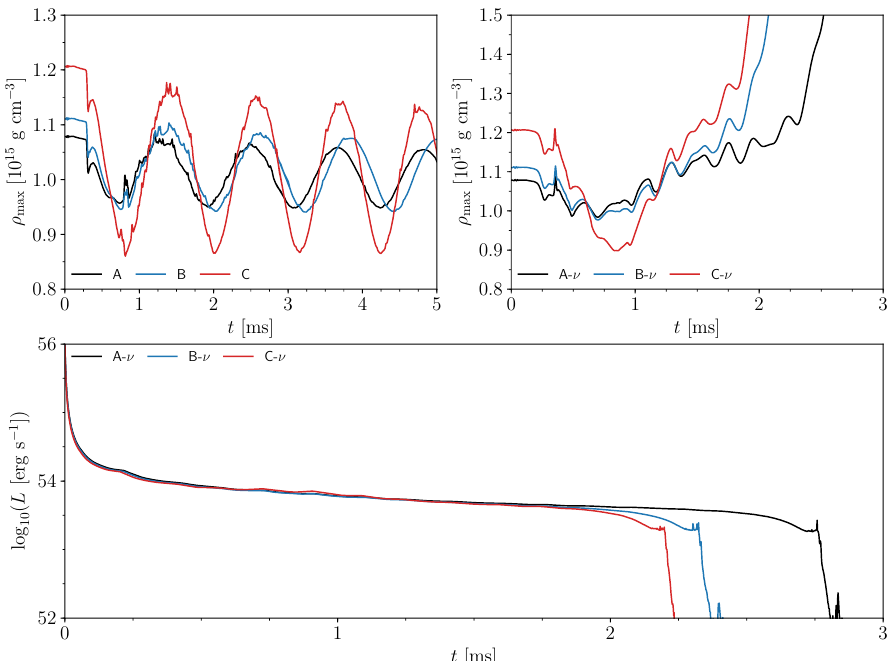
Figure 2. Time evolution of quantities of interest. Upper panels: central rest-mass density for simulations A, B, and C. Left panel: without NLS, where the density stably evolves around an equilibrium state for each run. Right panel: with NLS, where the wobbly evolution results from the coupling between the matter motion and the neutrinos emission. A final density growth marks the formation of an apparent event horizon. Lower panel: total luminosity evolution for simulations A- ν , B- ν , and C- ν . We notice a rapid burst at the beginning of the simulations. Likewise, the oscillating pattern of the luminosity is a consequence of the coupling between neutrinos and matter. After the formation of the apparent event horizon, the luminosity abruptly decreases.